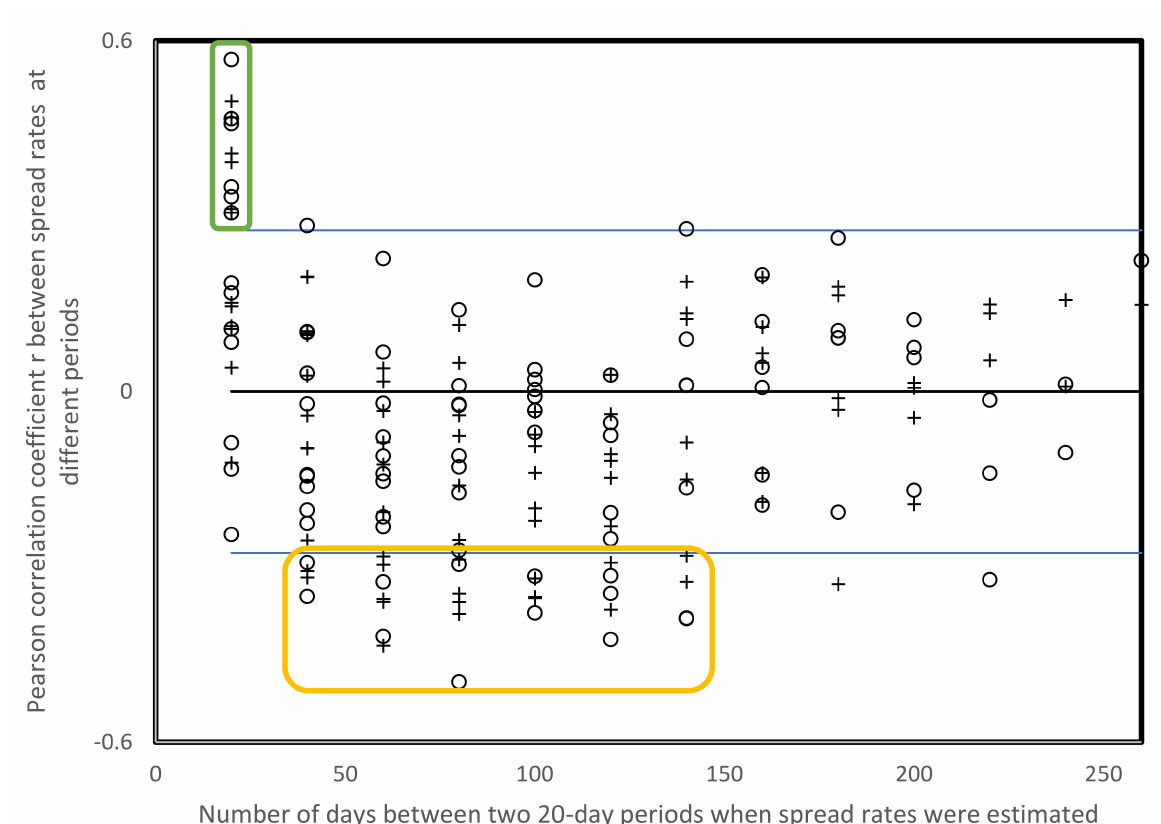
Figure 3. Pearson correlation coefficients r between spread rates from Tables 3 and 4 (open cirles, USA; and +, other countries, r from Table 5) as a function of numbers of days between the time frames when spread rates were estimated. Blue lines indicate crirical values of r for p < 0.05 according to two-tailed tests. Most positive r’s with p < 0.05 are for pairs of consecutive periods (20 days on x axis, green box), most negative r’s with p < 0.05 are for periods separated by approximately 80 days, orange